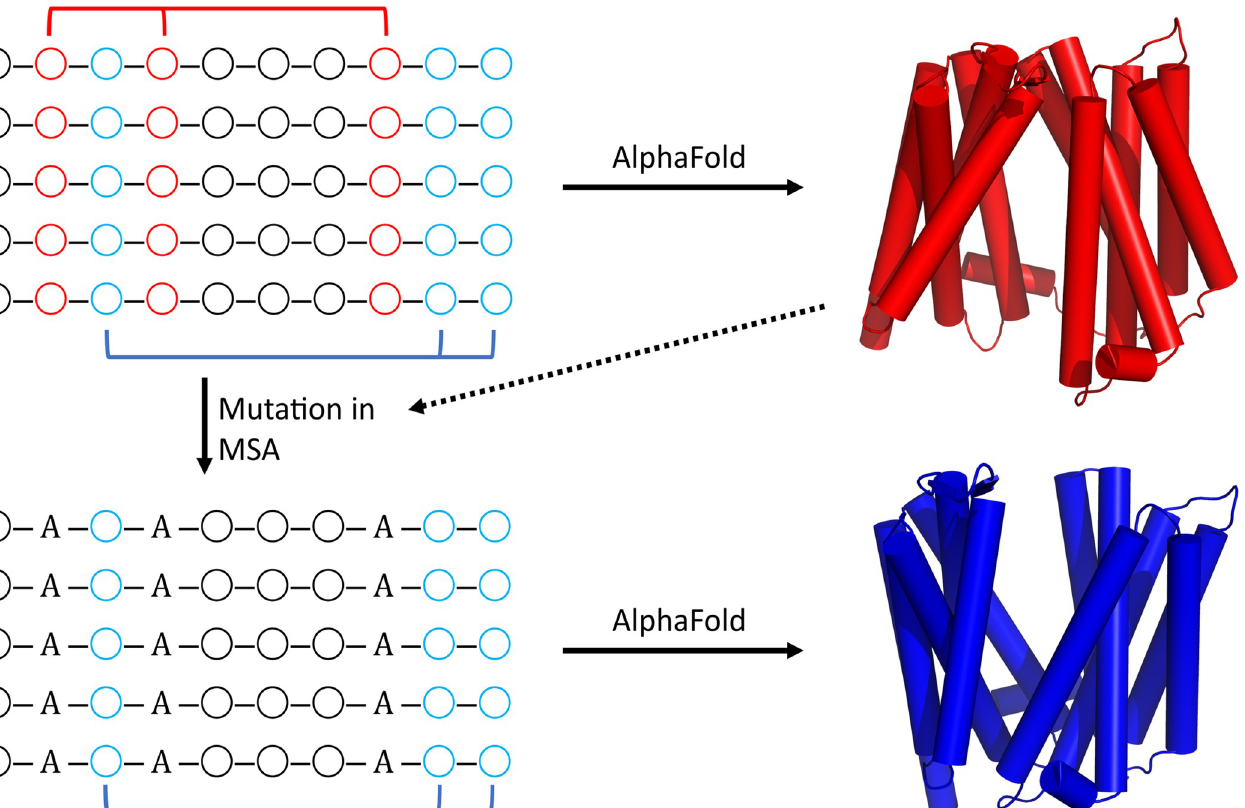
Fig 1. Methodology. An initially generated MSA, via MMSeqs2, is input into Alphafold2 within ColabFold to generate five structural models. For illustration, the model with the highest pLDDT, AF2’s ranking of model confidence, is shown in red. Residues for mutation are chosen, in this case the three residues in red mediating a contact point on the upper surface of the protein. These mutations are made across the entire MSA (ignoring gaps). This modified MSA is then input into ColabFold for generation of new models. With the contact points in red missing, Alphafold2 within ColabFold generates a new conformation based on the contacts shown in